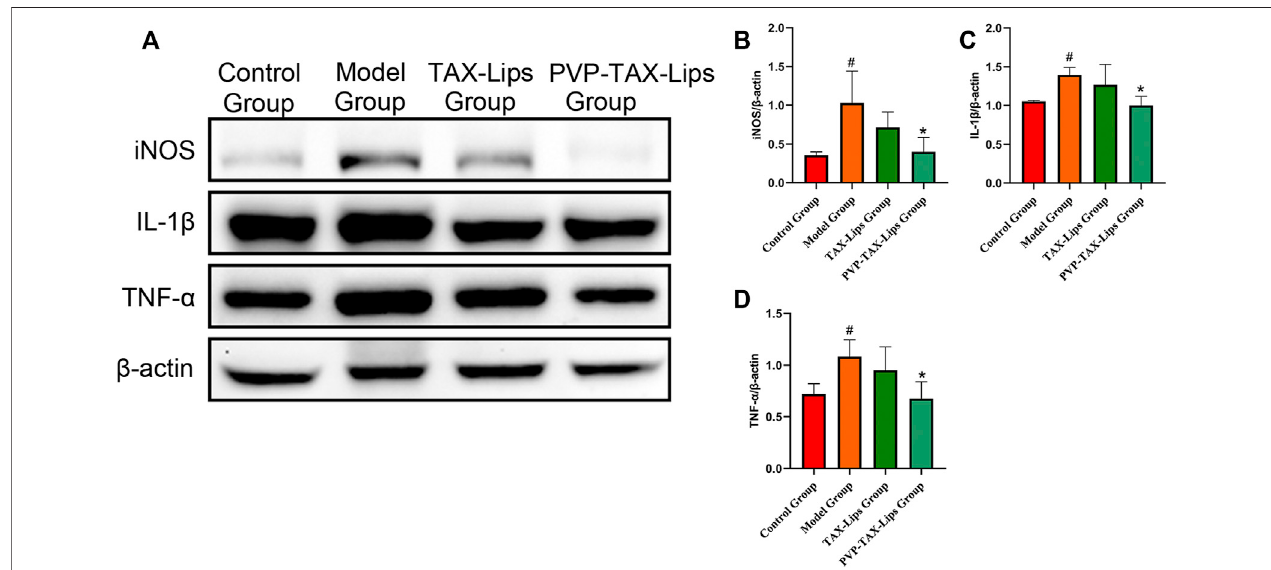
FIGURE5| In fl ammatoryfactorsinmicewithALIinducedbyLPS/D-GalN. (A) ProteinlevelsofiNOS,IL-1 β ,TNF- α ,and β -actinanalyzedbyWesternblotting. (B – D) Relative band intensity analyzed by ImageJ Analysis System, and β -actin was used as a control for equal loading. As compared with the control group, # p < 0.05. As compared with the model group, * p < 0.05. The data are presented as the mean ± SD ( n = 3).